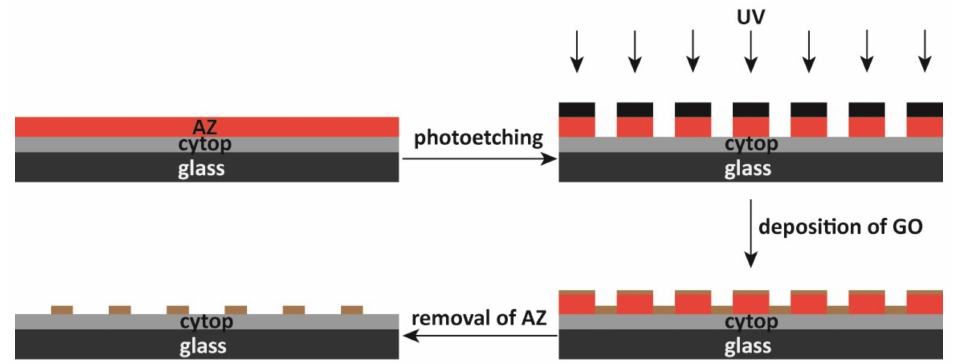
Figure 3. Scheme of patterning Cytop surface by graphene oxide using